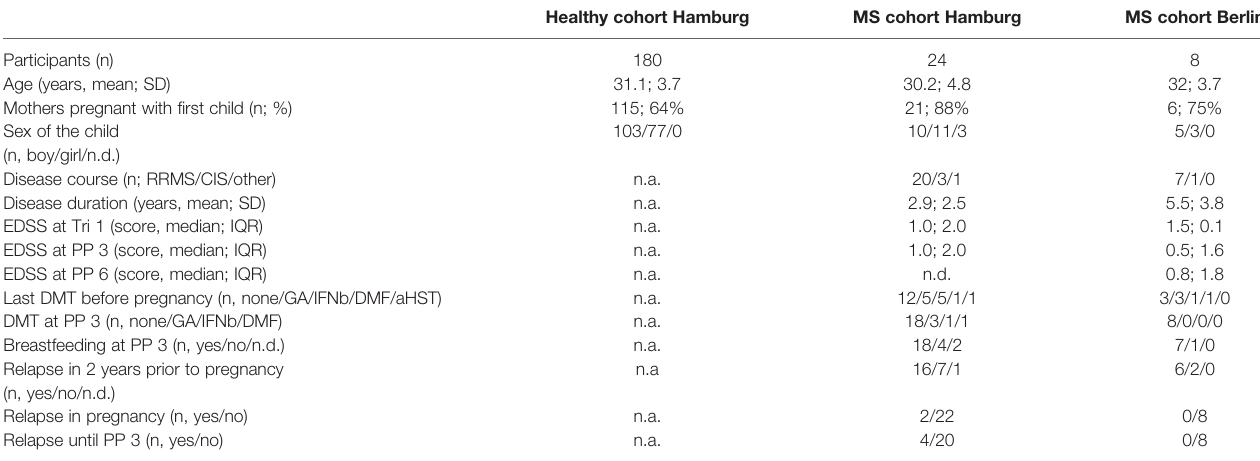
TABLE 1 | Demographics and MS